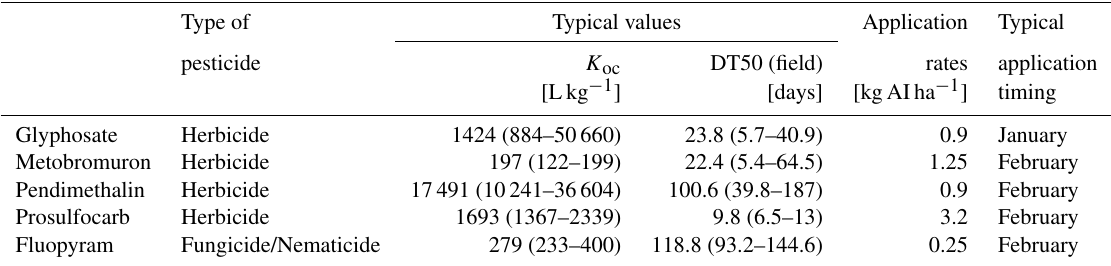
Table 2. Summary of pesticide properties considered in the model (Lewis et al., 2016) and mean application rates in the study catchment. The abbreviations and parameters used in the table are as follows: AI – active ingredient, K oc – pesticide adsorption coefficient on soil organic carbon, and DT50 – time for 50% of pesticide to be degraded in soil. The values shown are mean values, and the ranges are given in